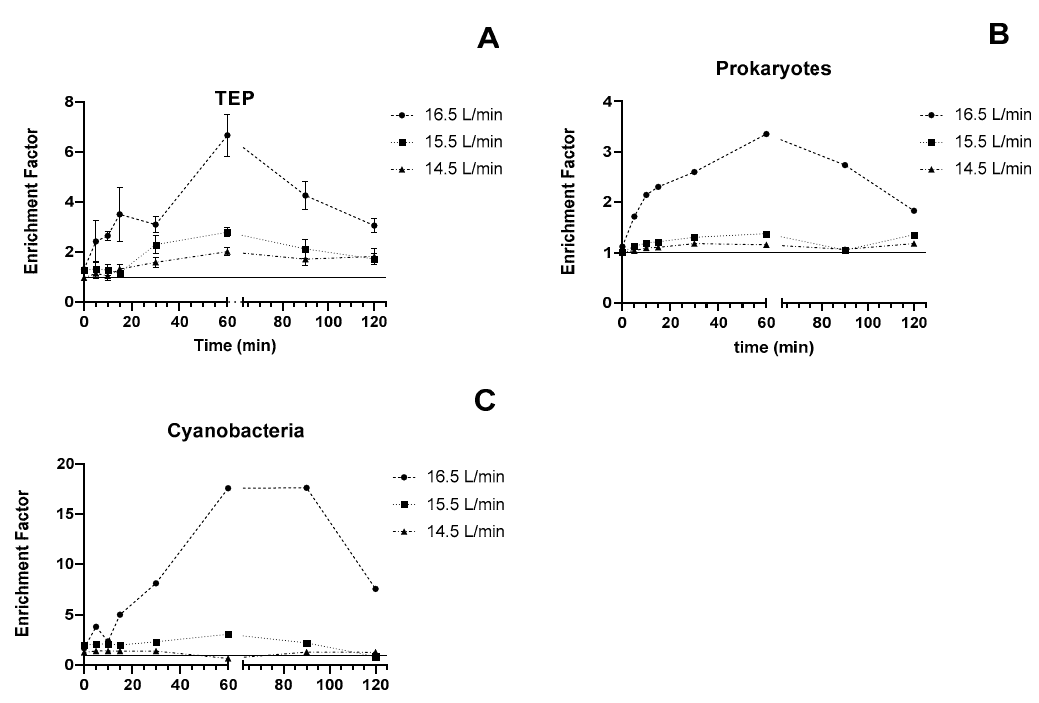
Figure 2. Temporal enrichment (enriched when enrichment factor (EF) > 1) of transparent exopolymer particles (TEP) ( A ), prokaryotes ( B ) and cyanobacteria ( C ) in three experiments with flow rates of 14.5, 15.5 and 16.5 L / min. Results are given as SML enrichment factors (i.e., concentration in SML / concentration in underlying water (ULW)). Bubbling was stopped at 60 min, noted by the break in the x -axis.